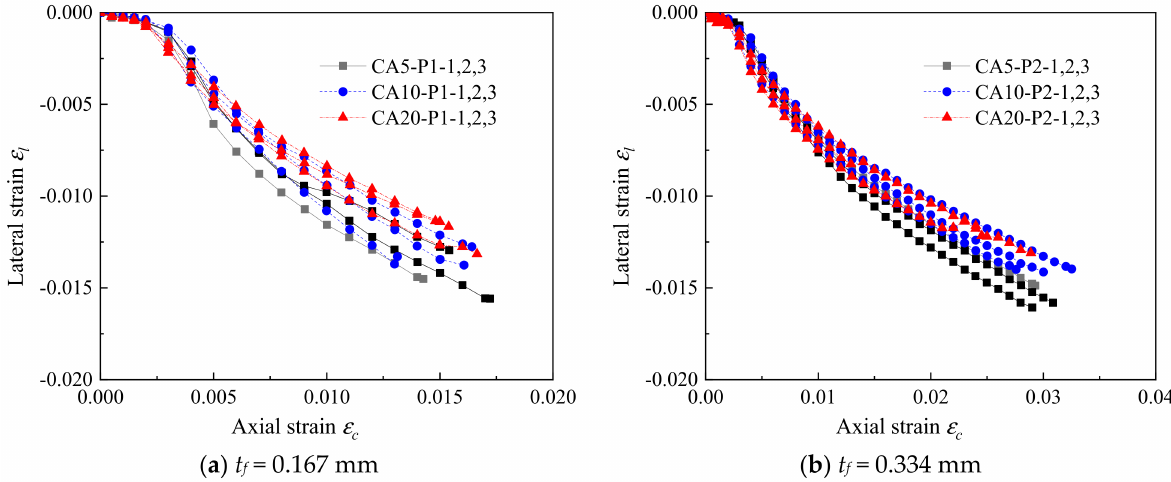
Figure 7. Effect of coral aggregate size on axial strain–lateral strain curves of confined